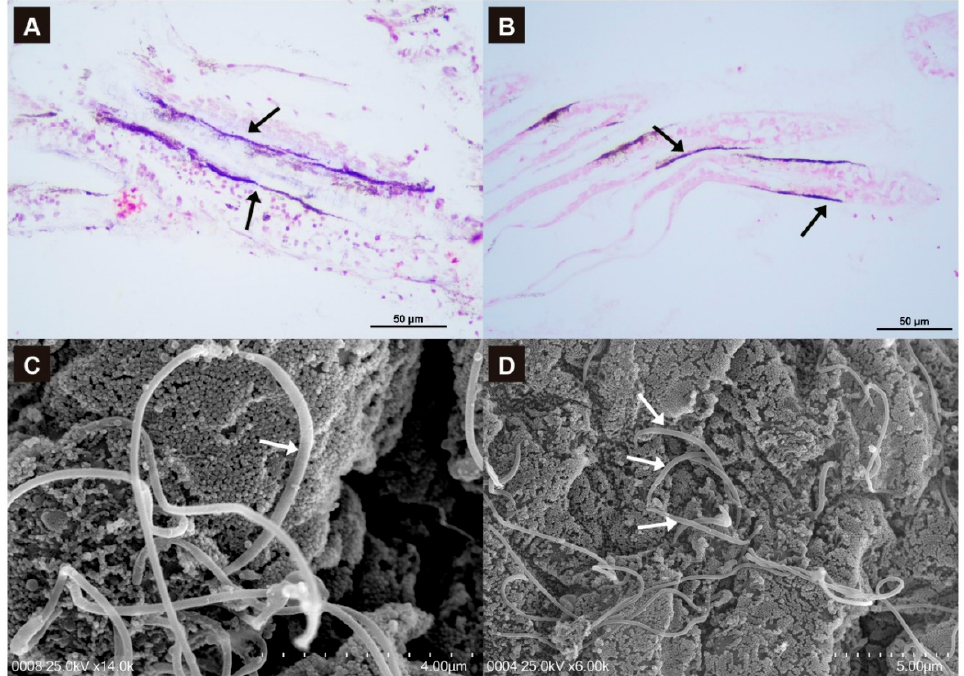
Figure 4. Localization of Campylobacterota in Argopecten purpuratus gills. In situ hybridization of symbiont-A ( A ) and -B ( B ) in scallop gill tissue. The labeling is observed microscopically as dark blue staining (arrows). ( C , D ). Scanning electron microscopy of scallop gills filament. Filamentous bacteria are observed (arrows).